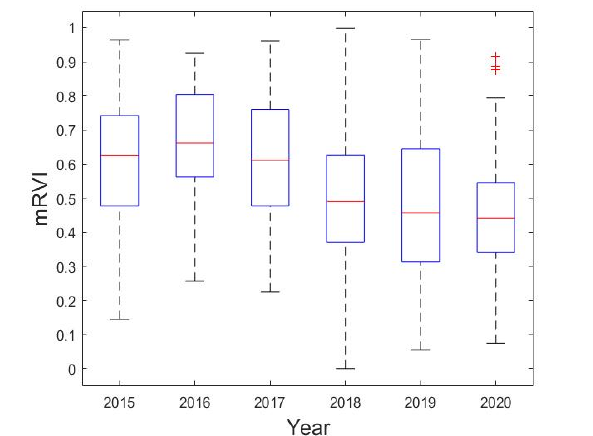
Figure 11. Boxplot of annual